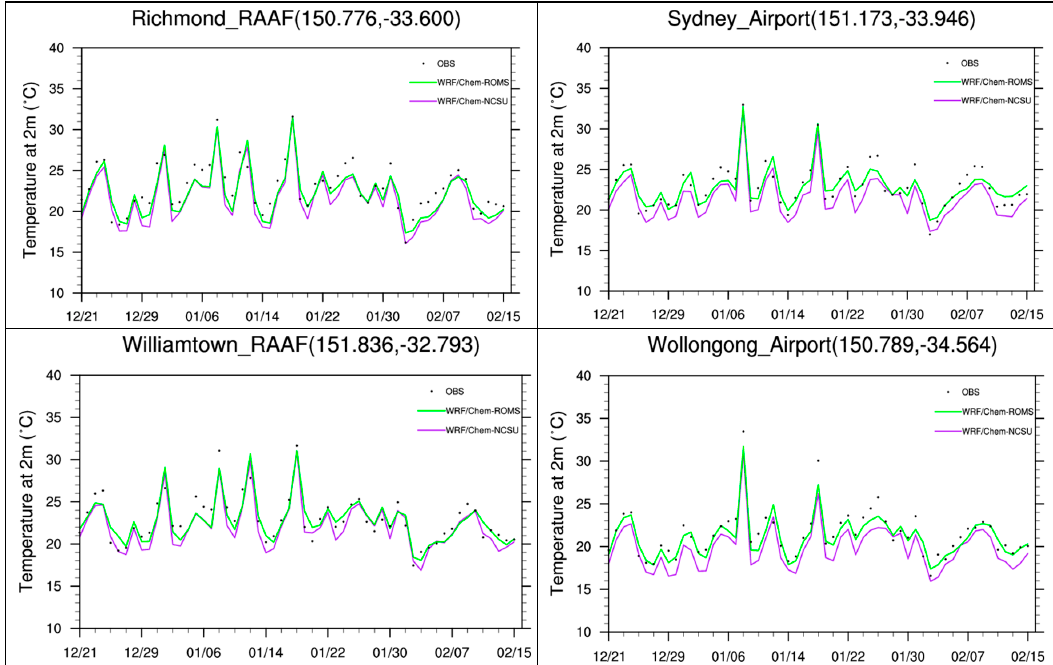
Figure 6. Observed and simulated temporal profiles of temperature at 2 m at selected sites over the Greater Sydney at 3 km (d04) during MUMBA. Two sets of simulation results at 3 km are compared, one from WRF/Chem-NCSU and one from WRF/Chem-ROMS.